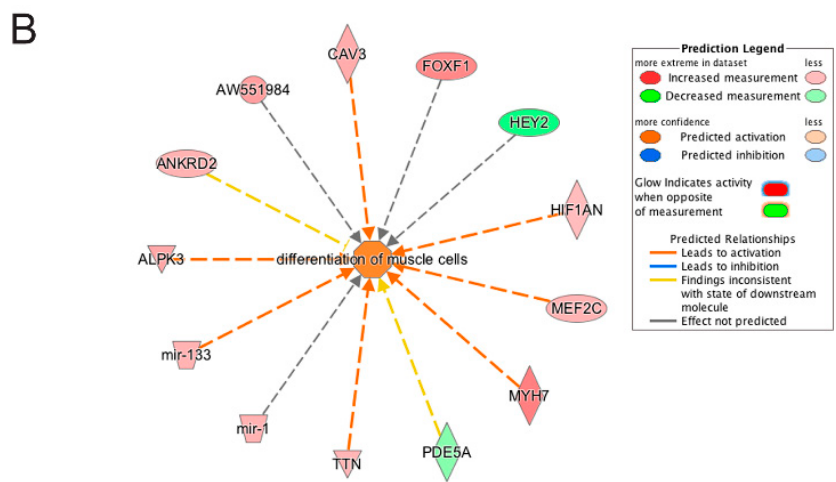
Figure 11. Ingenuity pathway analysis of differentially expressed genes unique to emerin-null cells during transition from day 1 to day 2 of differentiation. A, The Actin-Cytoskeleton signaling pathway was identified as a top canonical pathway in emerin-null cells. The network was generated through the use of IPA (Ingenuity Systems www.ingenuity.com) on normalized mRNA values. Nodes represent molecules in a pathway, while the biological relationship between nodes is represented by a line (edge). Edges are supported by at least one reference in the Ingenuity Knowledge Base. The intensity of color in a node indicates the degree of up- (red) or down- (green) regulation. Nodes are displayed using shapes that represent the functional class of a gene product (Circle = Other, Nested Circle = Group or Complex, Rhombus = Peptidase, Square = Cytokine, Triangle = Kinase, Vertical ellipse = Transmembrane receptor). Edges are marked with symbols to represent the relationship between nodes (Line only = Binding only, Flat line = inhibits, Solid arrow = Acts on, Solid arrow with flat line = inhibits and acts on, Open circle = leads to, Open arrow = translocates to). B, Biological Function Analysis with IPA on genes differentially expressed only in emerin-null cells during the transition from day 1 to day 2 of differentiation identified the activation of differentiation of muscle cells ( p -value: <0.001; Z -score: 1.263). The figure represents genes that are associated with a particular biological function that are altered in the uploaded dataset. Genes that are up-regulated are displayed within red nodes and those down-regulated are displayed within green nodes. The intensity of the color in a node indicates the degree of up-(red) or down-(green) regulation. The shapes of the nodes reflect the functional class of each gene product: transcriptional regulator (horizontal ellipse), transmembrane receptor (vertical ellipse), enzyme (vertical rhombus), cytokine/growth factor (square), kinase (inverted triangle) and complex/group/other (circle). An orange line indicates predicted upregulation, whereas a blue line indicates predicted downregulation. A yellow line indicates expression being contradictory to the prediction. Gray line indicates that direction of change is not predicted. Solid or broken edges indicate direct or indirect relationship,